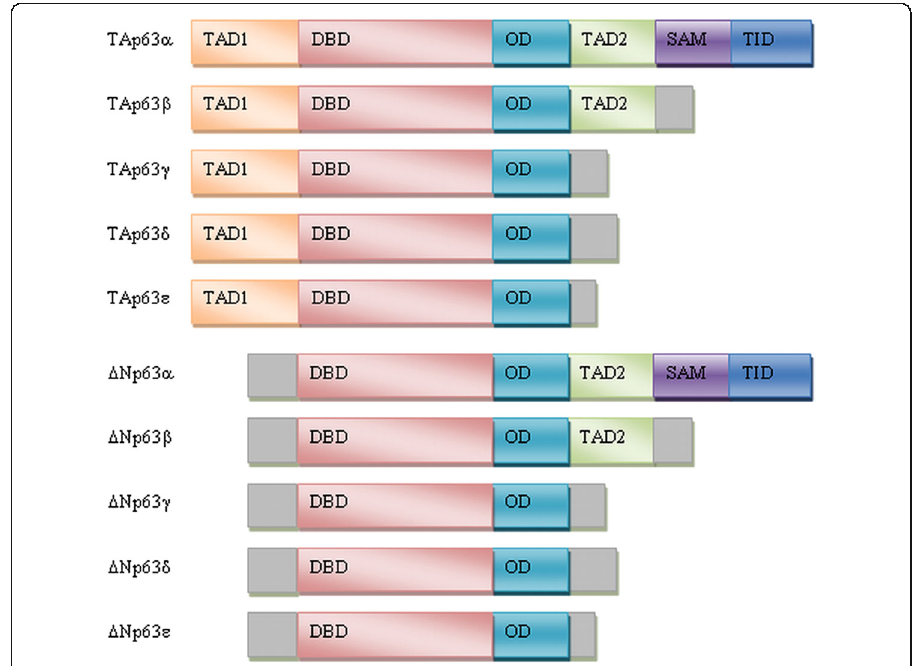
Fig. 6 Schematic overview of p63 isoforms – TAD1, transcription activation domain 1; DBD, DNA-binding domain; OD, oligomerization domain; TAD2, transcription activation domain 2; SAM, sterile α -motif; TID, transcription inhibitory